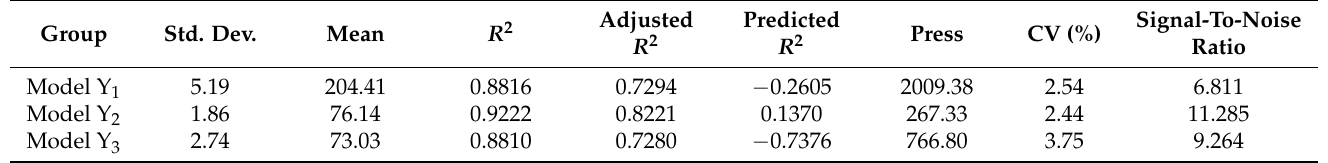
Table 10. ANOVA for developed response